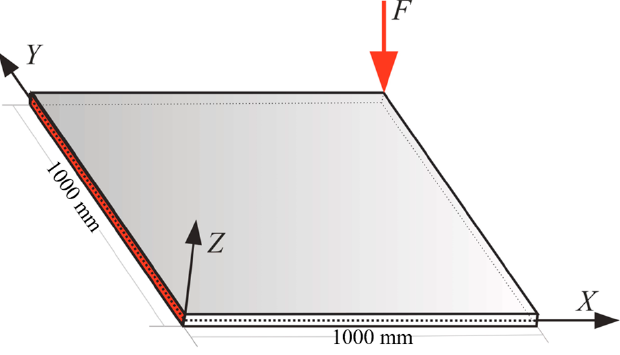
Figure 11. The cantilever plate under the concentrated force at its